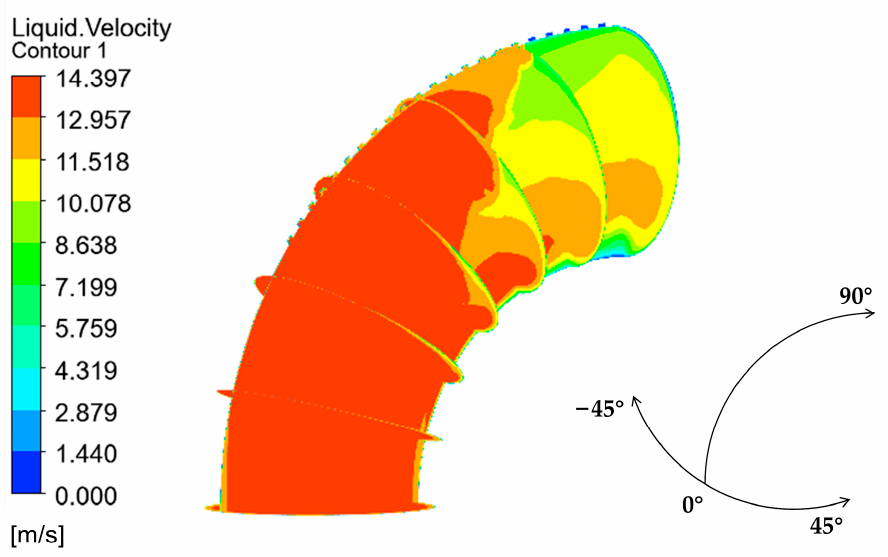
Figure 18. Velocity distribution and streamline of the liquid phase.